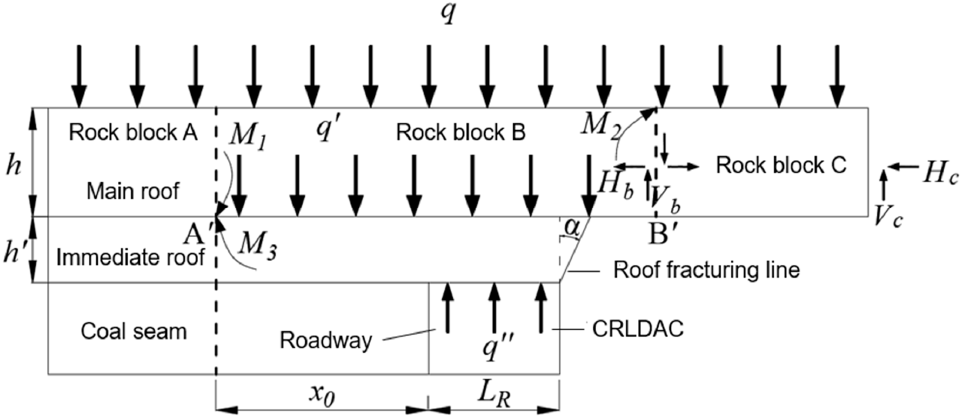
Figure 2. Mechanical model of roof structure of GERRCP.